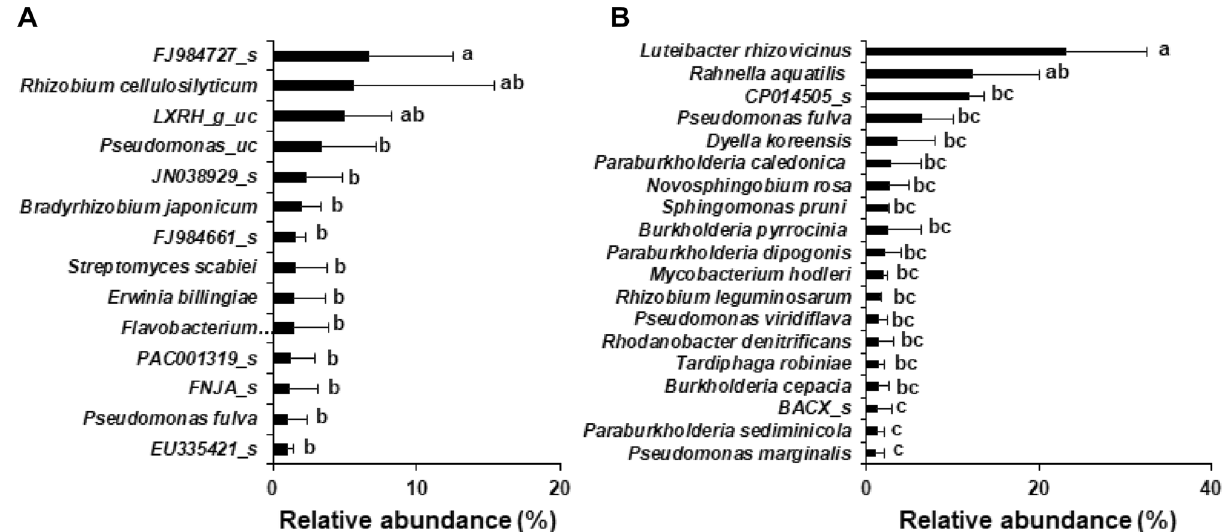
Figure 5. Relative abundance of bacterial species within the roots of Ulleung-sanmaneul plants. The bacterial species with relative abundance > 1% in roots were compared between wild ( A ) and cultivated ( B ) habitats. The data are represented as mean ± standard deviation and bars with the same letter do not differ significantly at P =